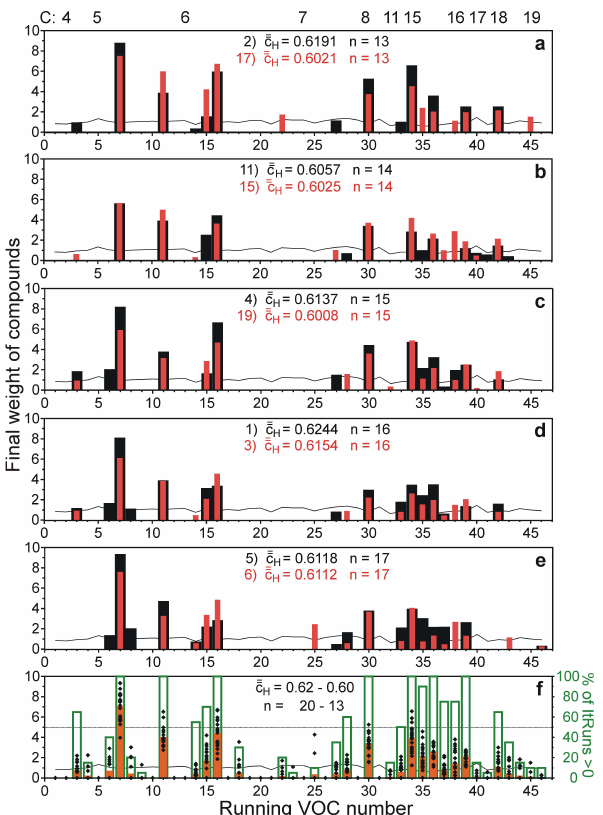
Fig. 3. (a–e) End stages of average weights of the 46 compounds (VOCs) in ten of the 20 ItRuns that reached the highest c H values. Each diagram contains the results of two ItRuns (one drawn black and one red) with an equal number ( n ) of remaining VOCs. Lead- ing numbers indicate the rank position (1–20) of c H . The undulating thin line around 1 gives the initial standardised values from which the ItRuns started. (f) Black symbols give 1–20 weights per VOC#, red columns resulting means (with zero values included). Green columns (right ordinate) give percentage of 20 ItRuns in which the respective VOC reached the end of 10 4 ItSteps . Numbers on top give related positions of n-alkanes with number of C atoms as indicated (see Table S1).